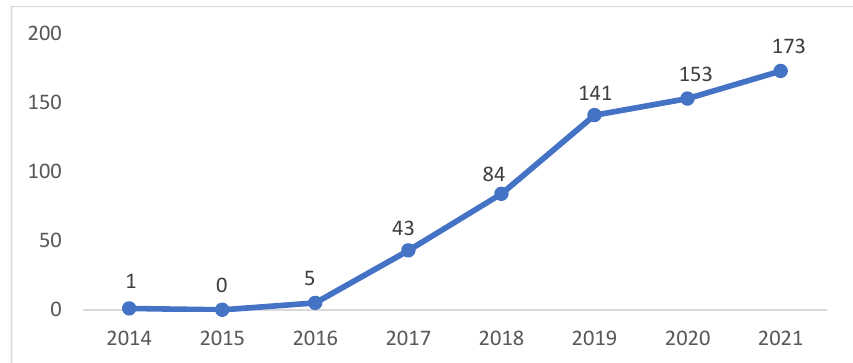
Figure 2. Annual scientific production. Source: own elaboration based on RStudio.